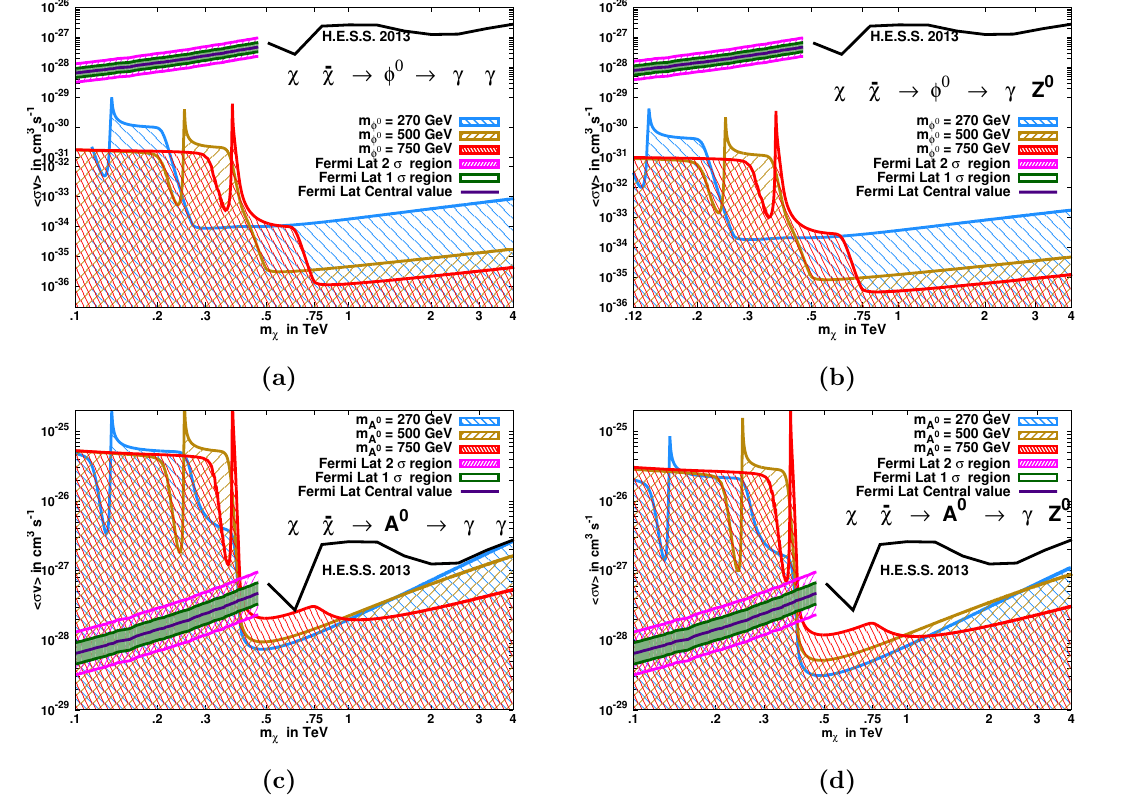
Figure 8. Figures 8a and 8b depict the thermal averaged cross-sections for fermionic DM pair annihilation (cid:31) (cid:22) (cid:31) ! (cid:30) 0 ! (cid:13)(cid:13) and (cid:31) (cid:22) (cid:31) ! (cid:30) 0 ! (cid:13)Z processes via scalar portal respectively. Figures 8c and 8d show the thermal averaged cross-sections for fermionic DM pair annihilation (cid:31) (cid:22) (cid:31) ! A 0 ! (cid:13)(cid:13) and (cid:31) (cid:22) (cid:31) ! A 0 ! (cid:13)Z processes via pseudo-scalar portal respectively. All the cross-sections are drawn for the upper limit on DM couplings allowed by the relic density constraints for a given DM mass. We have also exhibited the Fermi-LAT 1 (cid:27) and 2 (cid:27) limits for DM mass range < 500 GeV [13] and H.E.S.S. 2013 upper limit on the thermal averaged cross-section for DM mass range > 500 GeV [15] corresponding to (cid:13)(cid:13) and (cid:13)Z channels. Shaded regions appearing in blue, golden yellow and red correspond to the relic density forbidden regions for the portal masses of 270, 500 and 750 GeV